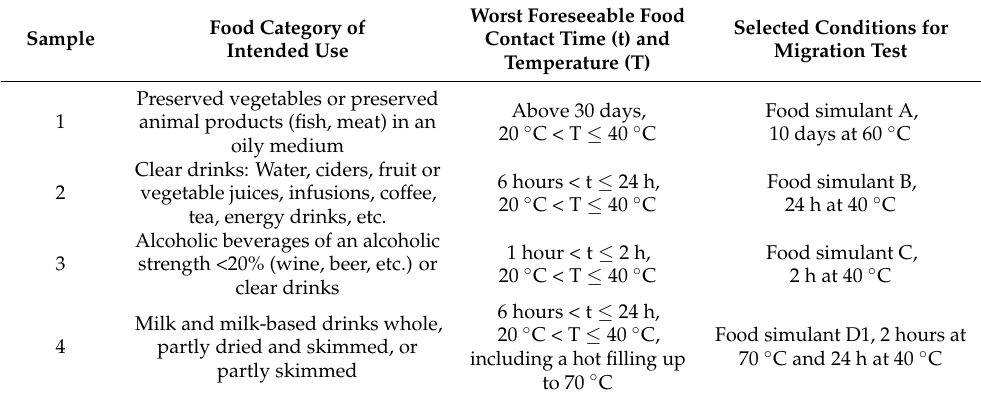
Table 3. Migration test conditions for the analyzed samples according to Regulation 10/2011